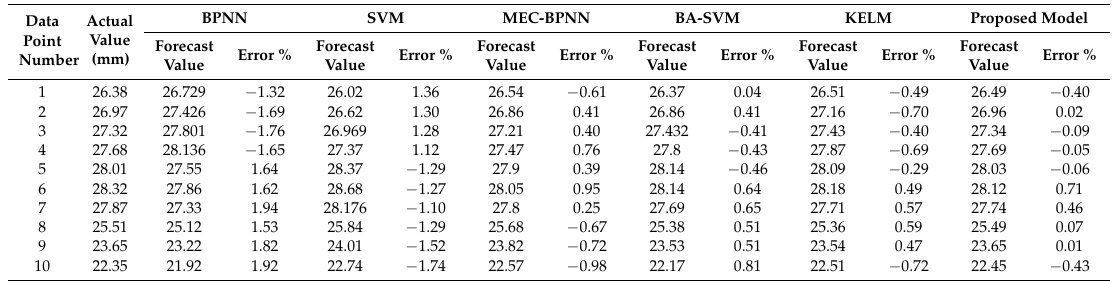
Table 5. Part of the forecasting value and relative errors of each